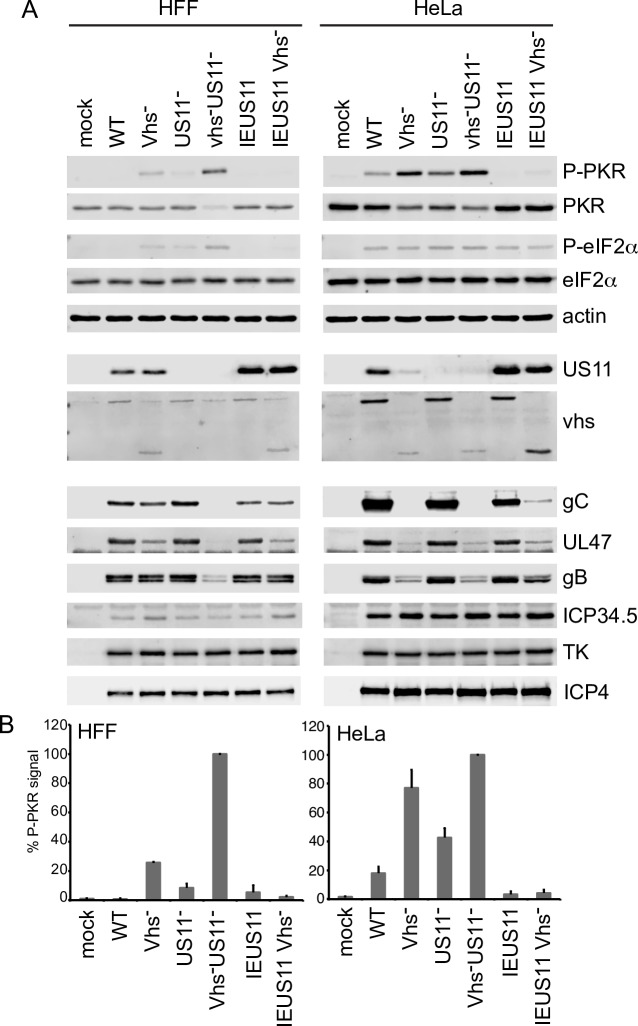
Vhs and US11 make independent and complementary contributions to PKR suppression during HSV infection.HFF and HeLa cells were infected for 12 hours with HSV-1 (KOS37) WT, Vhs-, US11-, Vhs-US11-, IEUS11 and IEUS11 Vhs- at an MOI of 10. A) Whole-cell lysates were analyzed by Western blot with the indicated antibodies. Note that the Vhs antibody used cross-reacts with a co-migrating cellular protein present in HFF cells. B) Quantification of the P-PKR signal in HFF and HeLa cells. Data are from 4 independent experiments. The P-PKR signal in cells infected with Vhs-US11- was set at 100%.